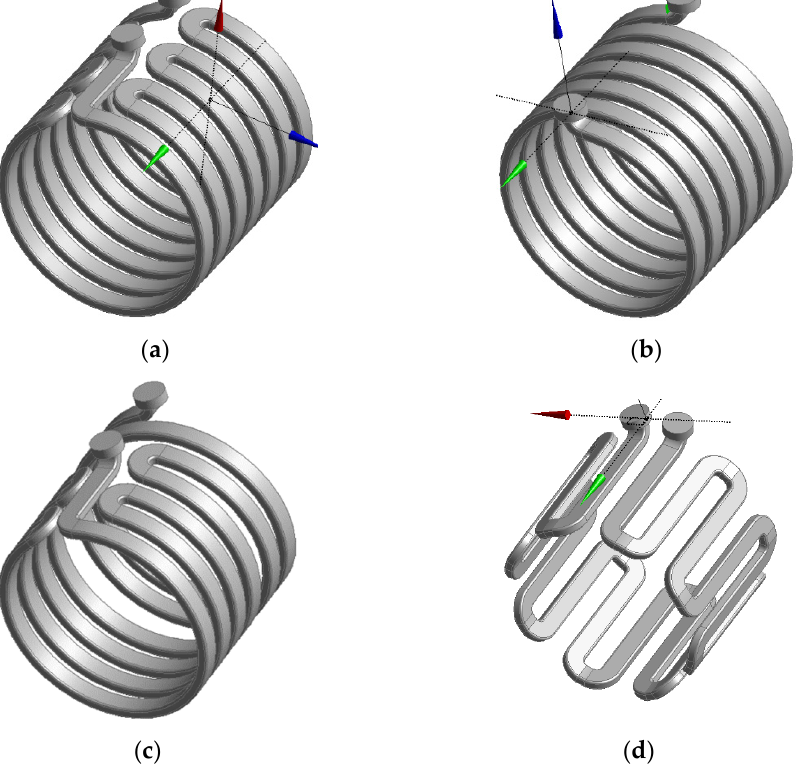
Figure 13. Various jacket configurations [95]: ( a ) circumferential structure; ( b ) helical structure; ( c ) half-helical structure; ( d ) axial structure.